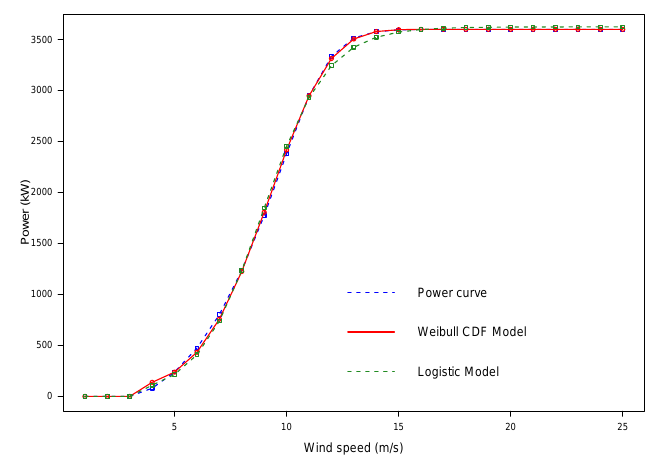
Figure 6. Weibull CDF and 4P-OP models for the Siemens 107 2-MW power curve.